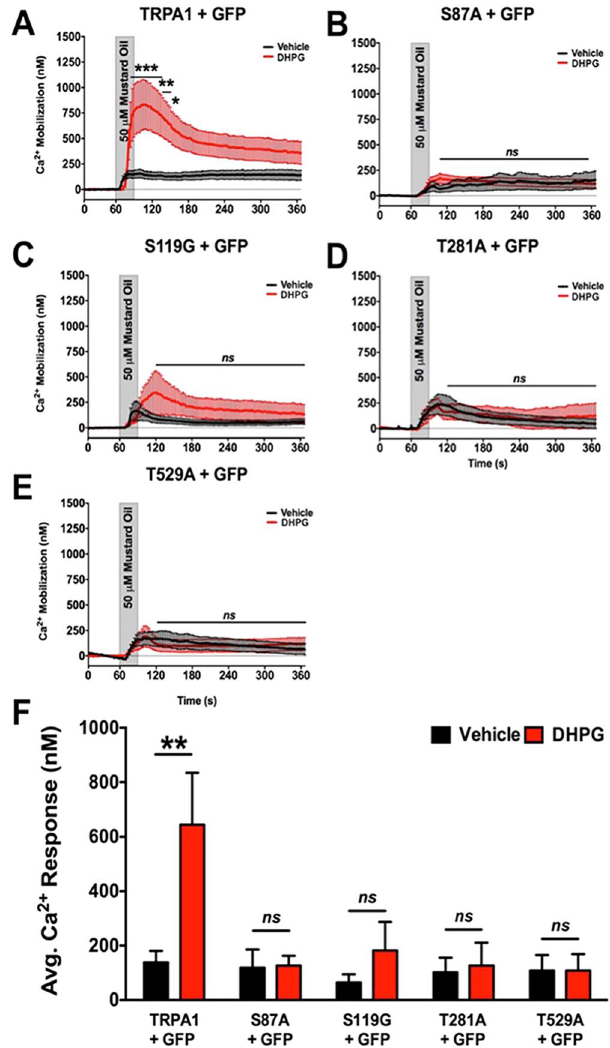
Figure 9. mGluR5-sensitization of TRPA1 Requires PKA and PKC-phosphorylation Sites. Mustard oil (MO, 50 μ M)-activated Ca 2 + mobilization was monitored from DRG sensory neurons harvested from TRPA1 KO mice and transfected with cDNA corresponding to green fluorescent protein (eGFP-N1, GFP) and either mouse TRPA1 WT (TRPA1, A ), mouse TRPA1 S87A (S87A, B ), mouse TRPA1 S119G (S119G, C ), mouse TRPA1 T281A (T281A, D ), or mouse TRPA1 T529A (T529A, E ). For 5 min prior to recordings, DRG were pre- incubated for 5 min in vehicle (ddH2O) or DHPG (10 μ M), then DRG were challenged with MO (30 sec)